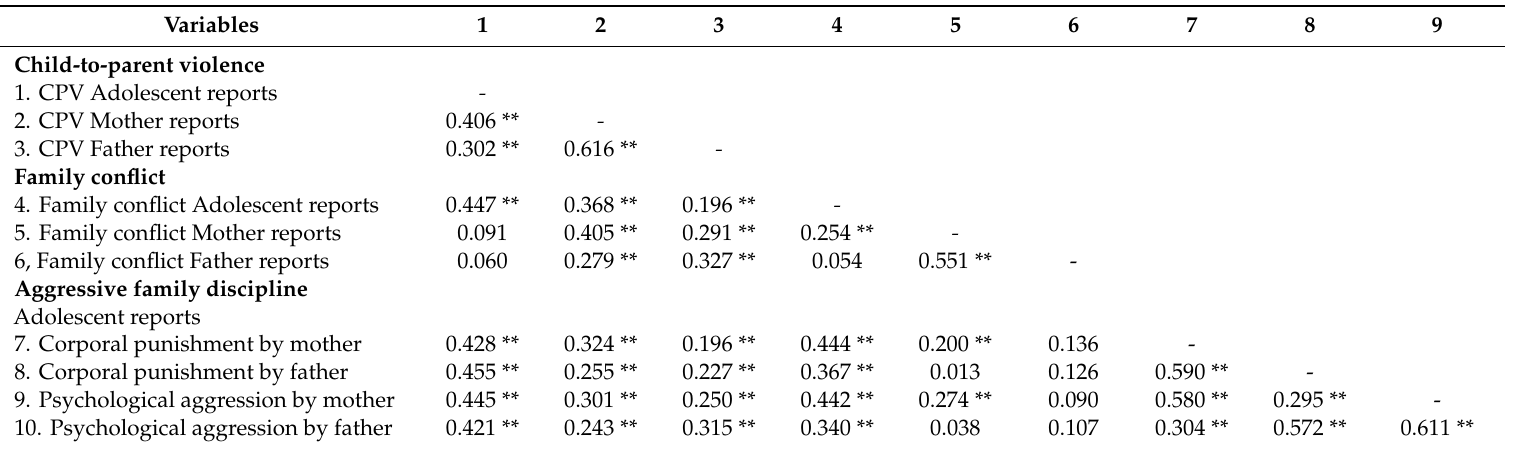
Table 2. Correlation matrix of family variables